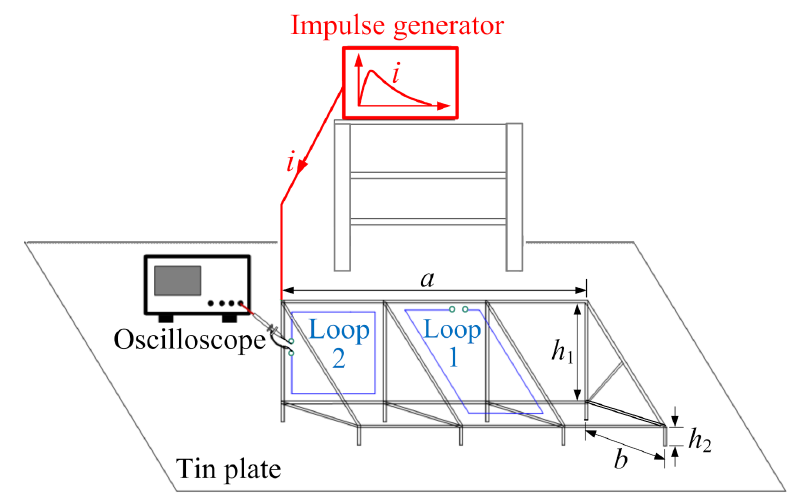
Figure 7. Measurement on reduced-scale experimental set-up.